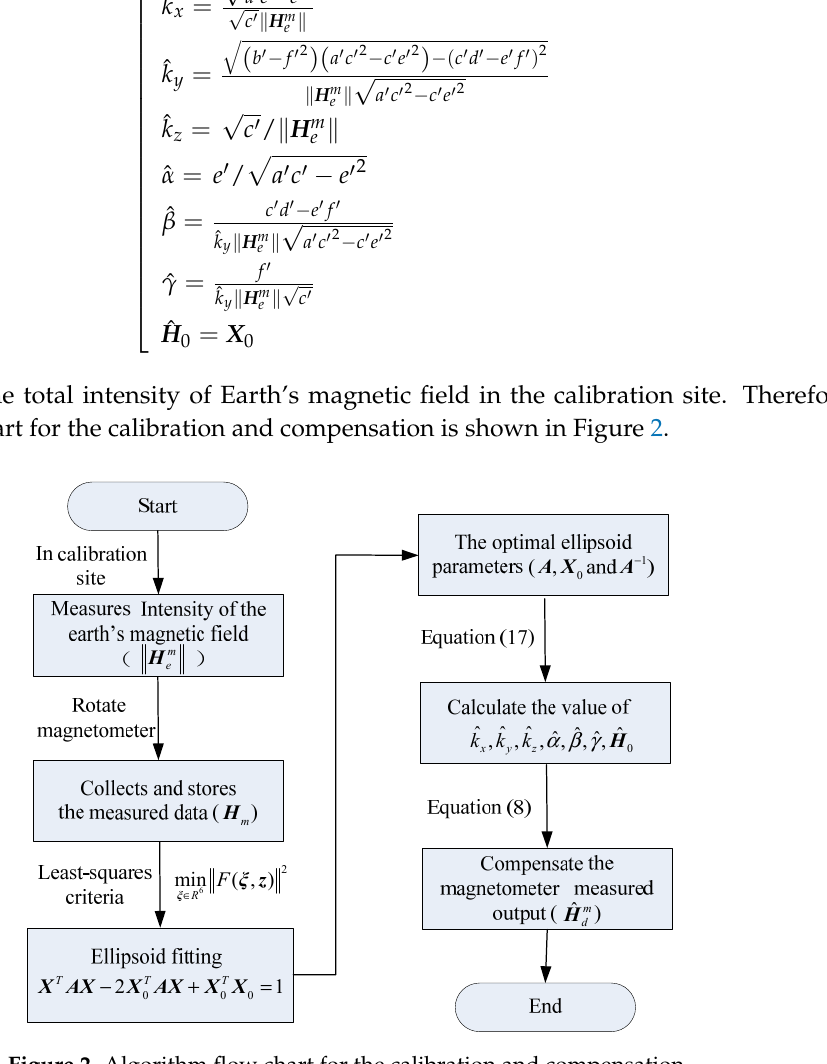
Figure 2. Algorithm flow chart for the calibration and compensation.